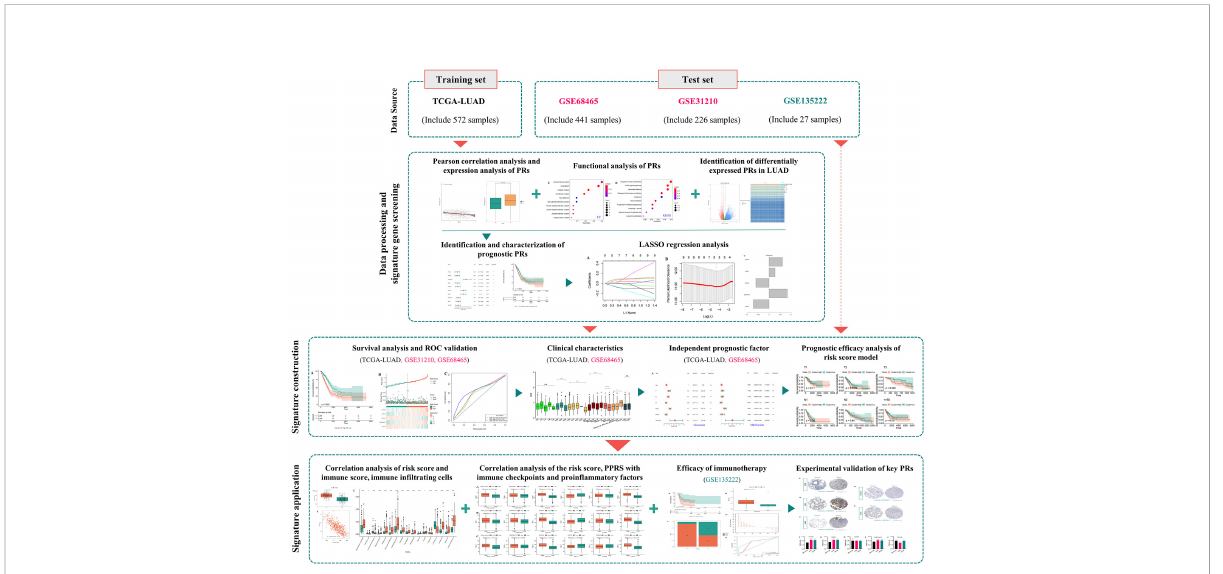
FIGURE 1 The analysis fl owchart for identi fi cation and validation of a novel phagocytosis regulators-related signature with potential prognostic and immunotherapeutic value in